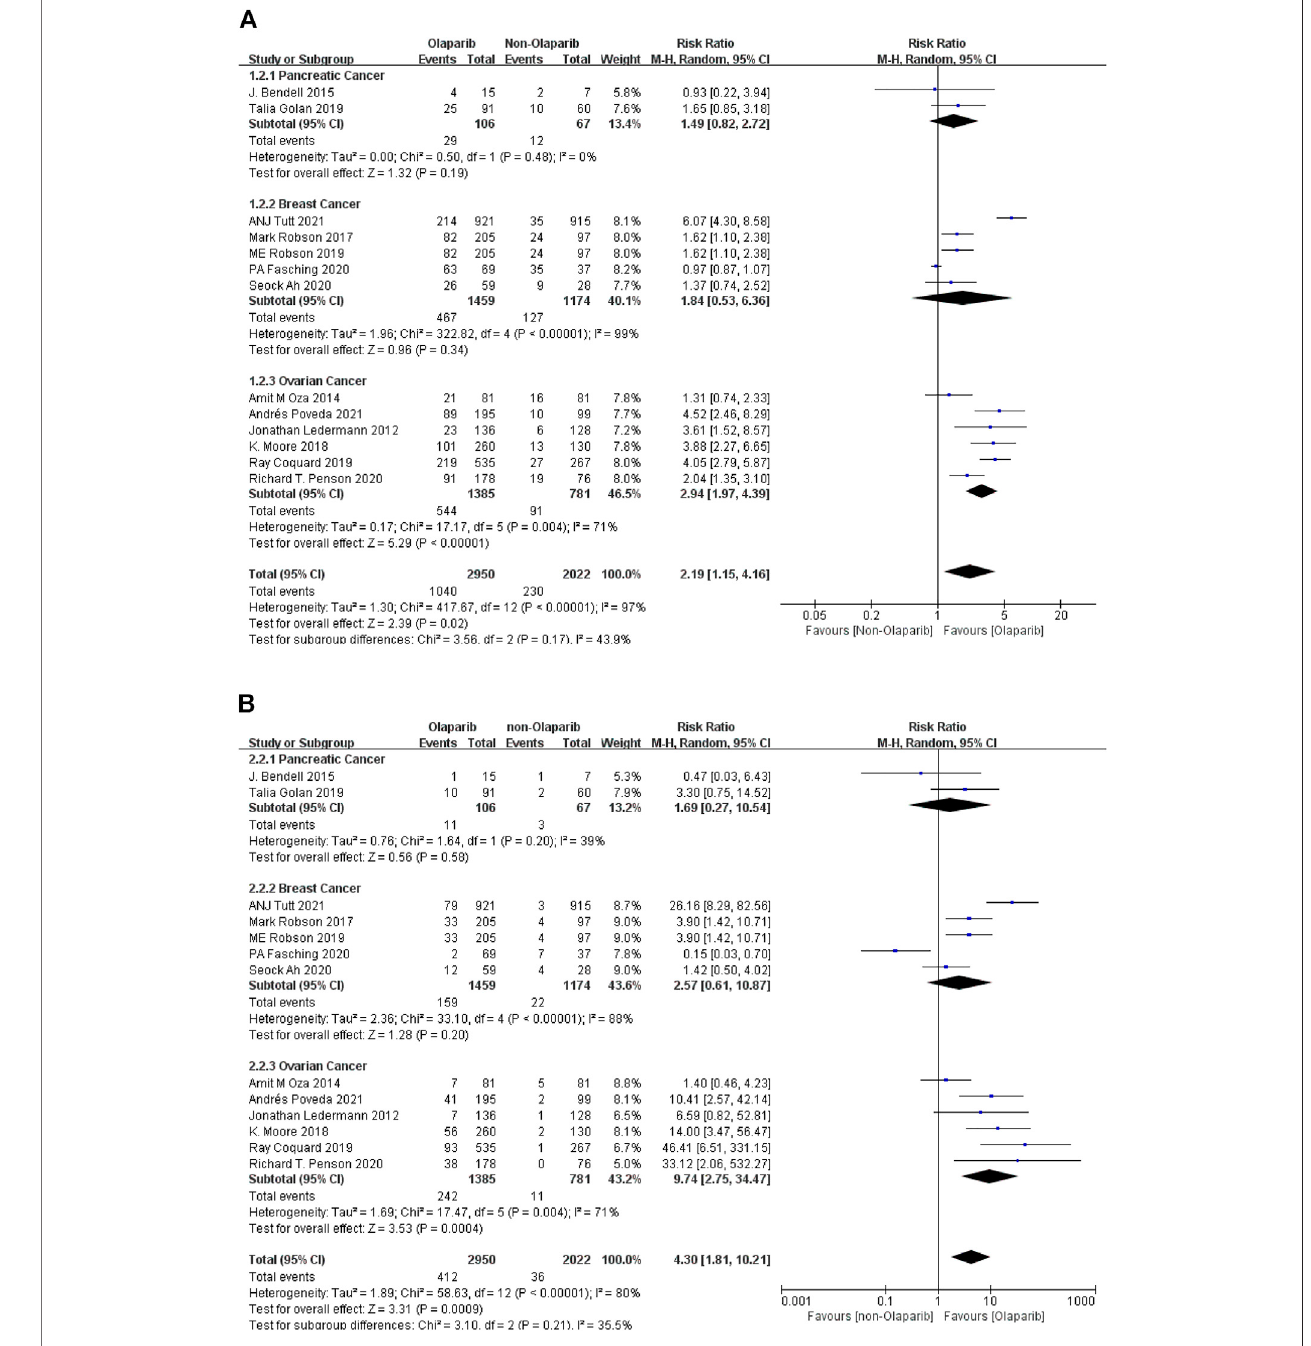
FIGURE3|(A) Meta-analysisofany-gradeadversereactionsofanemiacausedbyOlaparibfordifferentindications. (B) Meta-analysisofgrade3oraboveadverse reactions of anemia caused by Olaparib for different indications.